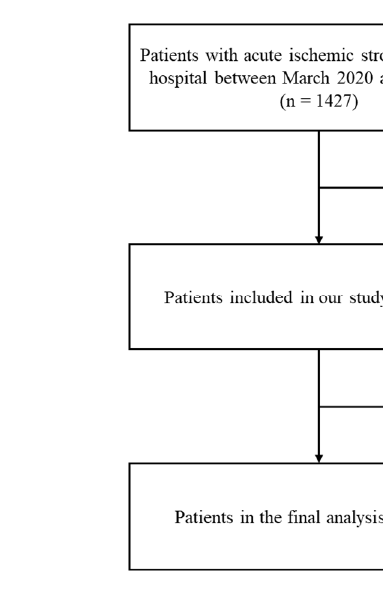
Figure 1. Flow diagram for patient selection. Table 1. Baseline characteristics according to tertiles of NLR.